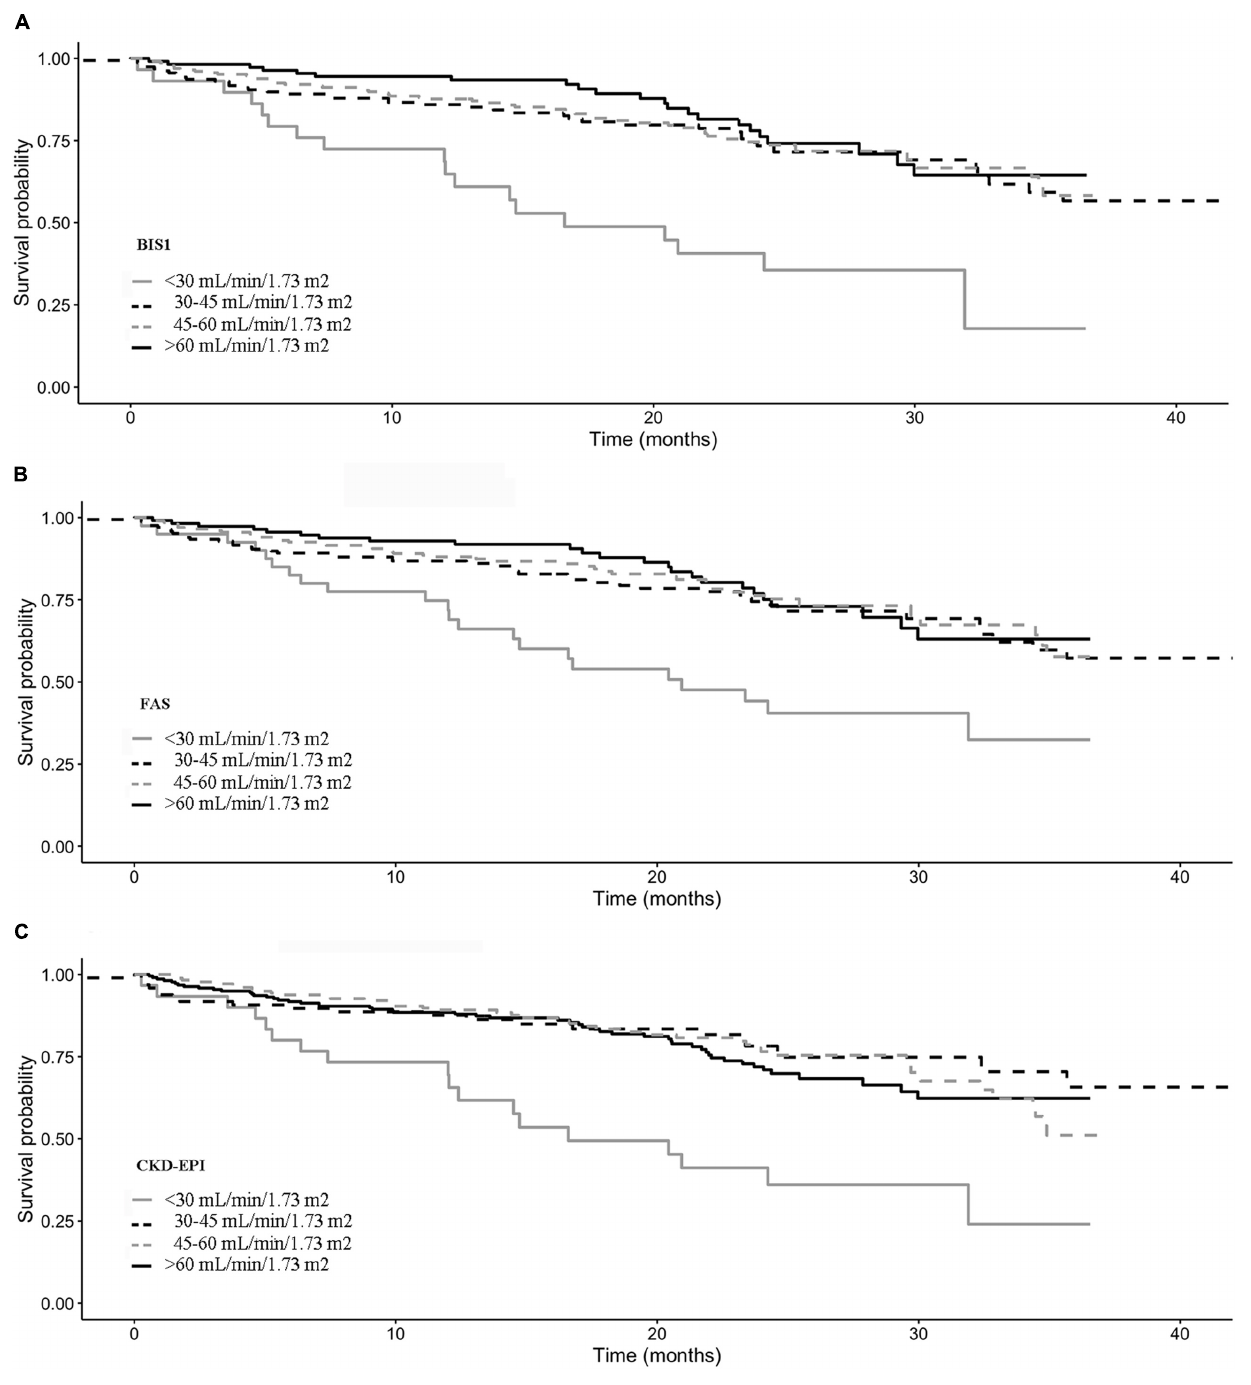
FIGURE 5 | Kaplan–Meier survival curves according to the eGFR categories for (A) BIS1, (B) FAS, and (C)